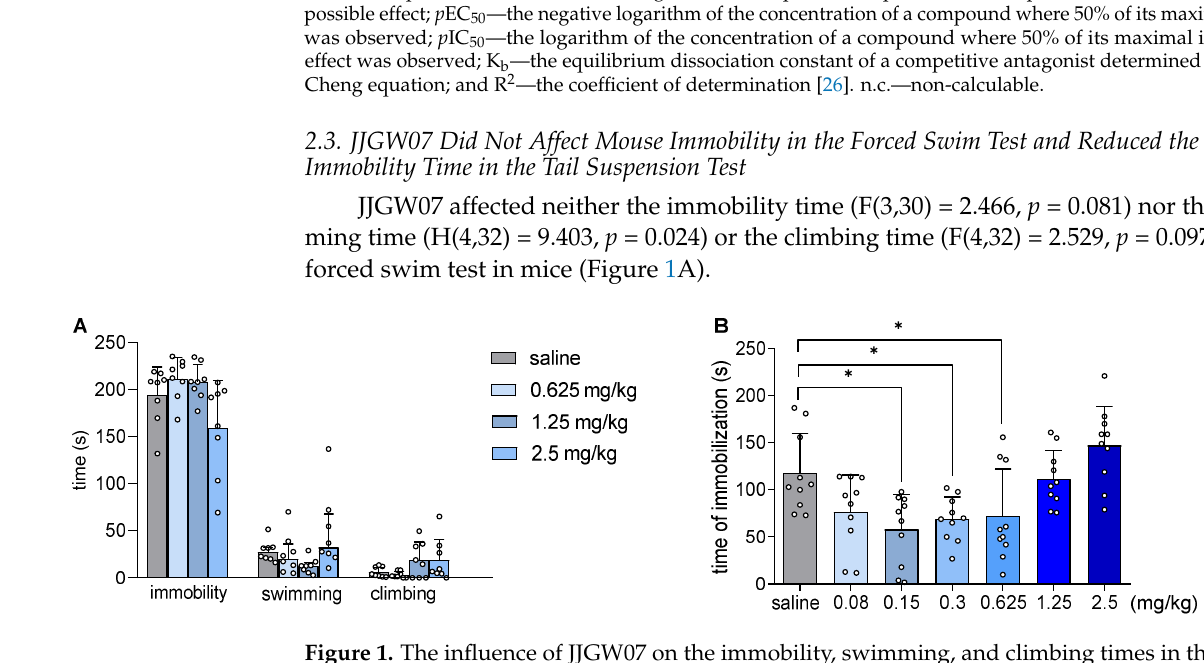
Figure 1. The influence of JJGW07 on the immobility, swimming, and climbing times in the forced swim test (panel ( A )) and the immobility time in the tail suspension test (panel ( B )) in mice. In the forced swim test, mice were placed in water tanks and the immobility time, the swimming time, and the climbing time were measured for 4 min (after a 2 min adaptation period), whereas in the tail suspension test, mice were suspended by the tail 50 cm above a flat surface with an adhesive tape and the immobility time was measured for 6 min. JJGW07 was administered intraperitoneally ( ip ) 30 min before the test. The control group received an injection of 0.9% NaCl ( ip ). Values are expressed as means ± SD or medians with interquartile range; n = 8–10 mice per group. Statistical analysis: one-way ANOVA (Newman–Keuls post hoc) and Kruskal–Wallis test (Dunn post hoc); * p < 0.05 vs. control group.